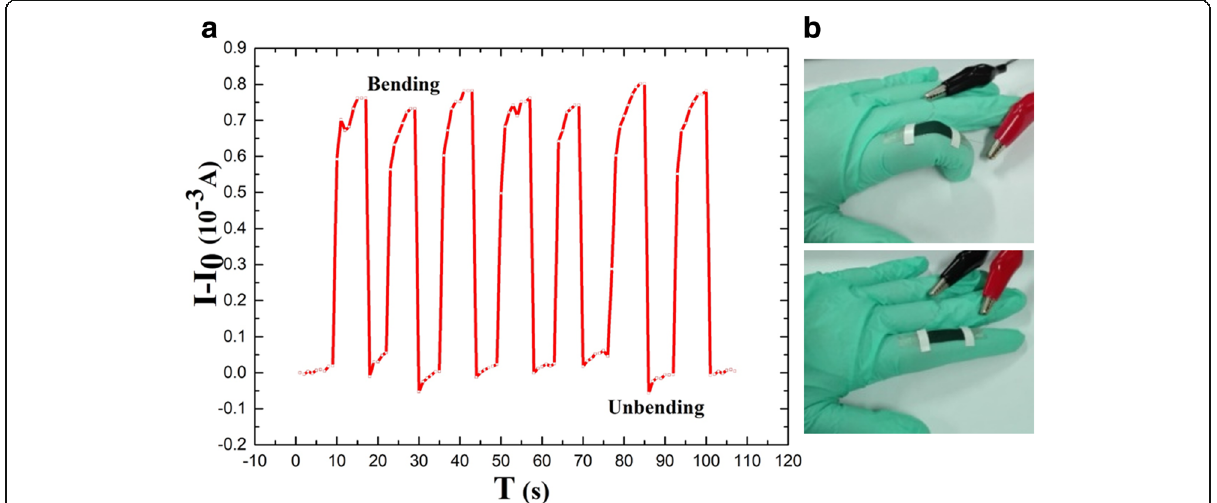
Fig. 9 a Current responses of the finger motion and photographs of the wearable PANI/TPU membrane sensor. b Optical images of the finger motion